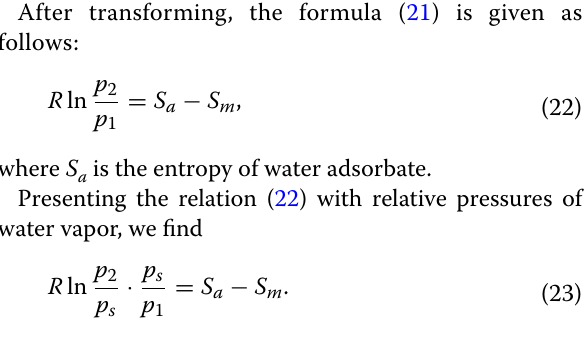
Thus, the excess of value p 2 over p 1 indicates the increase in the entropy change during adsorption. In par- ticular, it is also valid for water bilayer adsorption under standard conditions. Analysis of the adsorption isotherm of water vapor on cotton cellulose (Fig. 2) shows that the filling of water monolayer is completed at p 1 /p s meanwhile, the filling of water bilayer is completed at p 2 /p s 42%. Applying the numerical values to Eq. (23) = results that the difference between entropies of second and first adsorbed layers is 11.13 J/(K mol). This positive value indicates that water molecules in the first layer are more ordered than in the second one, which is in agree- ment with the above assumptions.